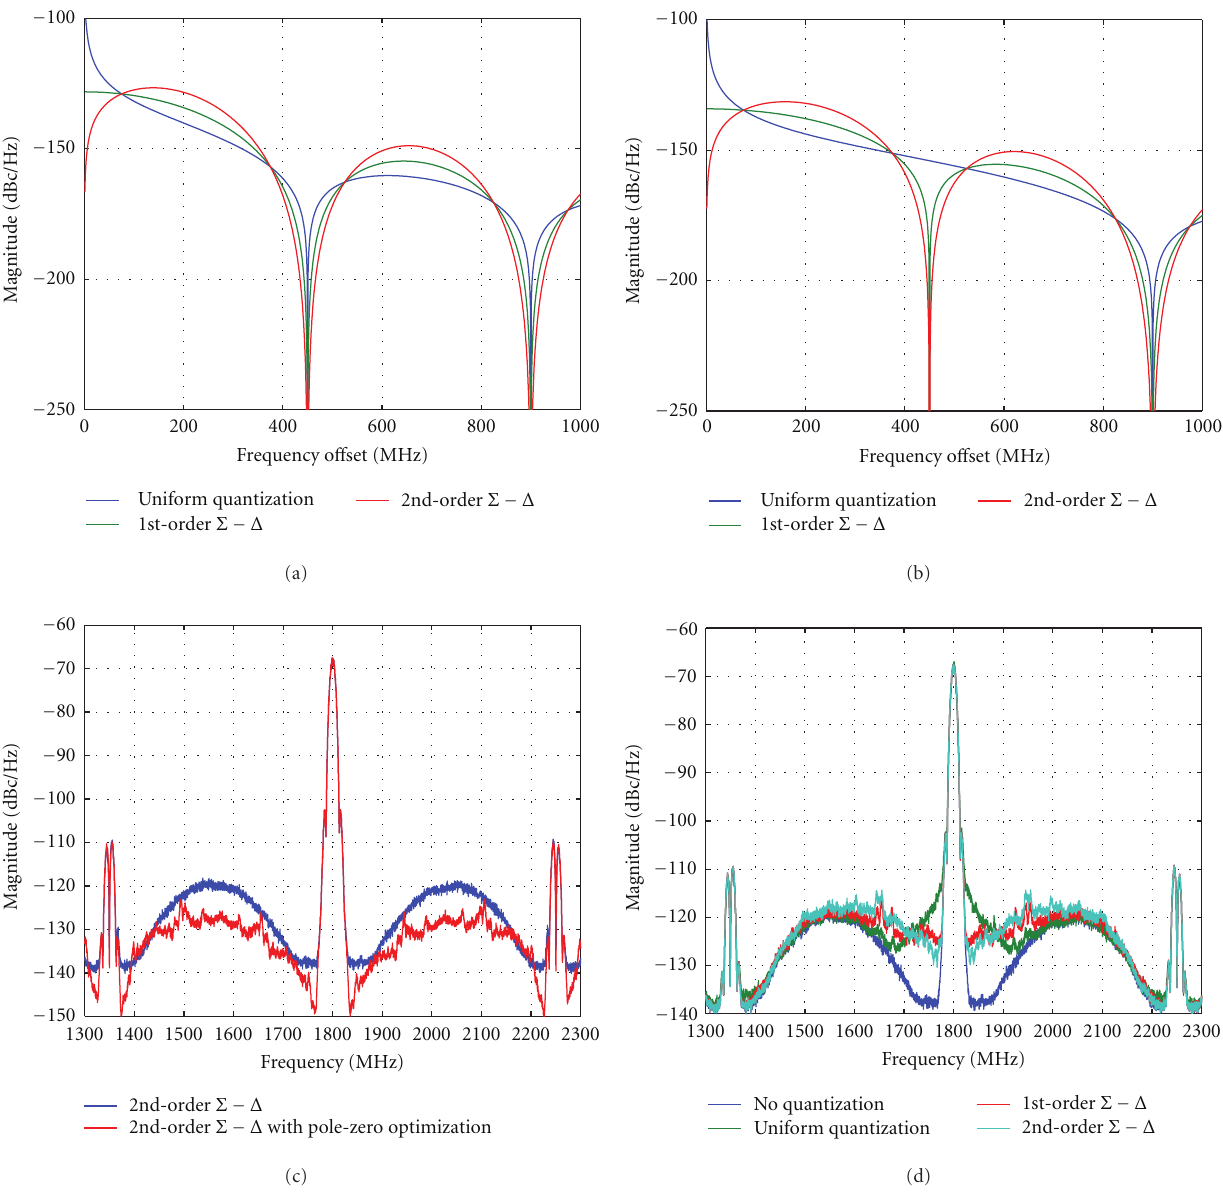
Figure 11: Plot of analytical expression for output quantization noise due to quantization in the cancellation path for (a) integration time of T s and (b) integration time of T s / 2. The simulated PSD of a GFSK-modulated signal showing (c) PQN reduction with poles in the NTF of phase path and (d) impact of quantization in the cancellation path using three types of